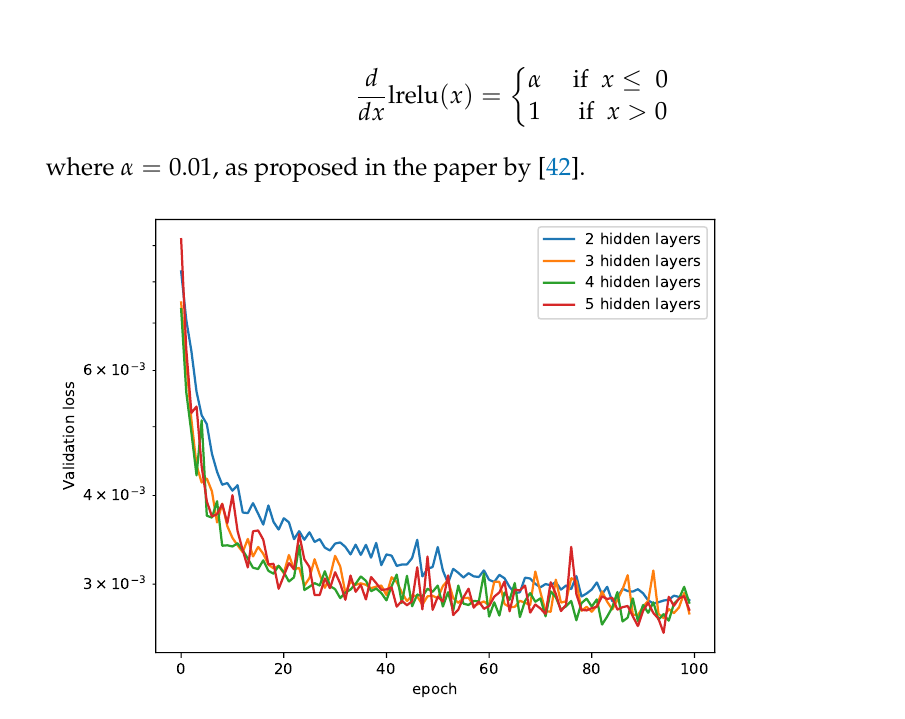
Figure 19. Comparison of the validation loss for various hidden layer sizes with log-scale. The num- ber of neurons is 512 for the 3D-truncated icosahedron